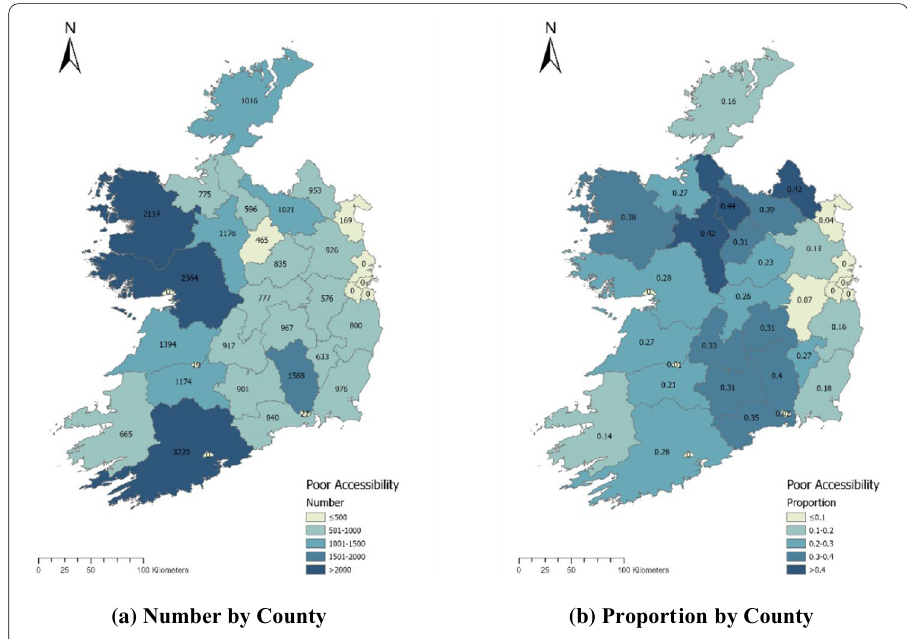
Fig. 3 Number and proportion of enrolments from at-risk electoral divisions by county. Source: Analysis of data from HEA, GeoDirectory, and National Broadband